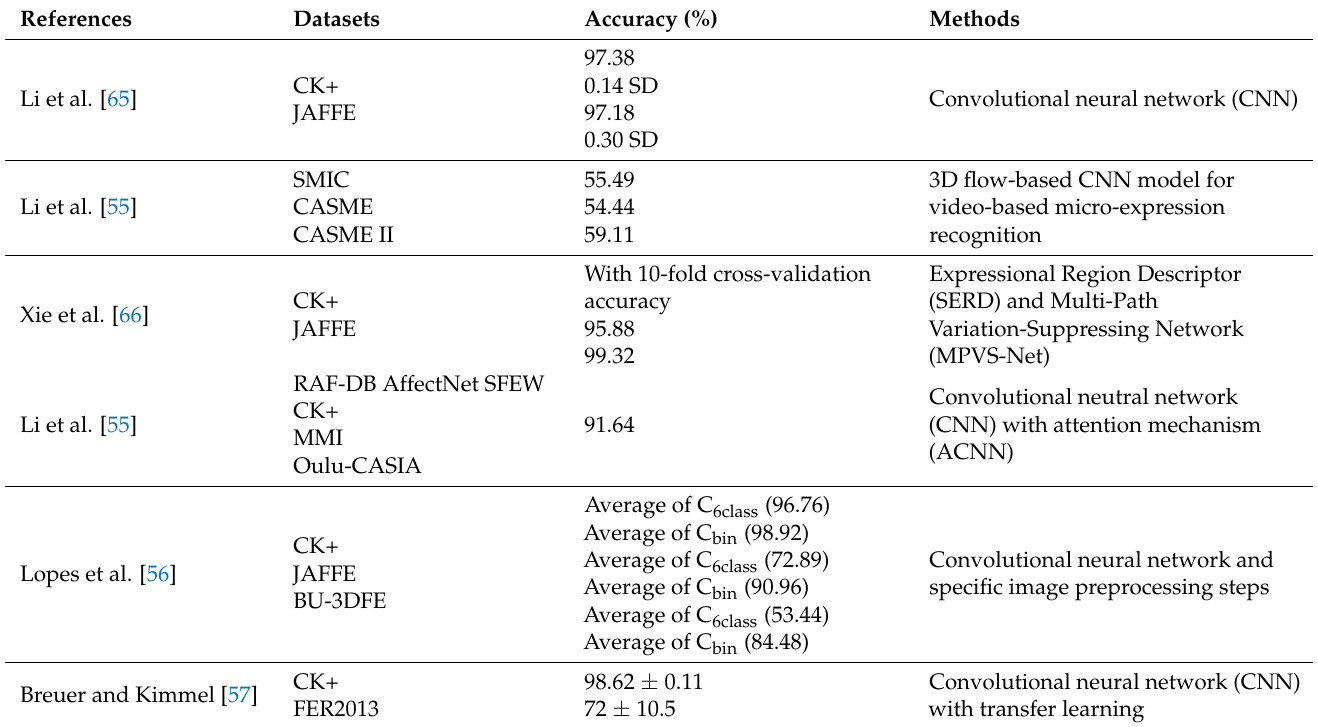
Table 4. Comparisons of deep-learning-based approaches for